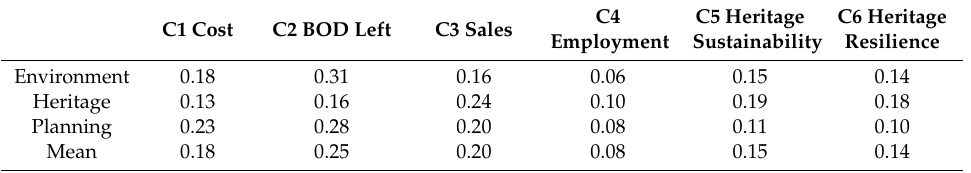
Table 5. Weighting of the three experts representing the conflicting stakeholder